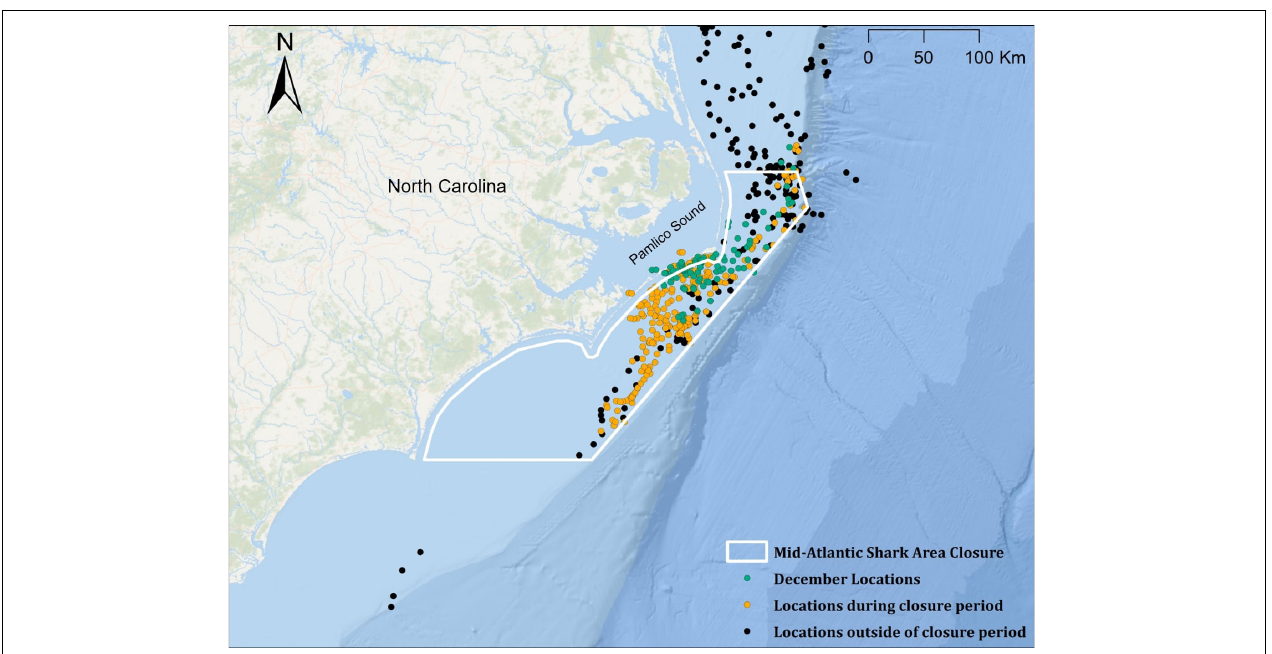
FIGURE 3 | Locations of juvenile smooth hammerhead sharks ( n = 4 for all groupings) within the mid-Atlantic Shark Area (MASA) during the closure period (January 1–July 1; orange points), and outside of the closure period (black points). Nearly all December locations (green points) fall within the MASA boundary but not within the closure period.